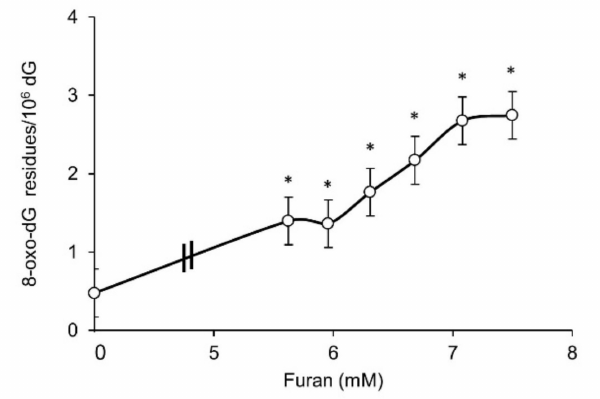
Figure 2. DNA 8-oxodG levels in L5178Y cells after 24 h exposure to furan at the indicated doses as measured by HPLC/EC. DNA 8-oxodG levels are expressed × 10 6 dG. Bars indicate SD. * p < 0.05 by Student t